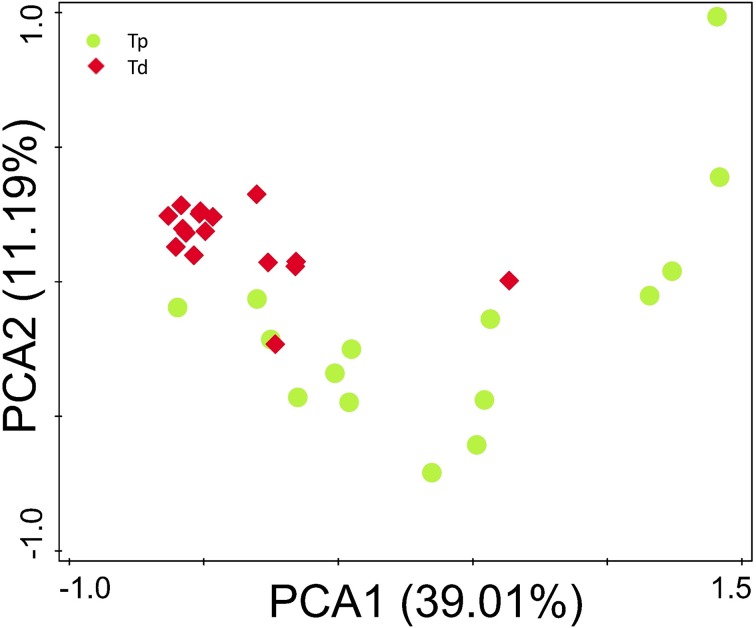
Principal component analysis (PCA) scores plot based on the relative abundance of OTUs (97% similarity level). Each symbol represents a sample. Green circles represent proximal CRC. Red quadrates represent distal CRC.